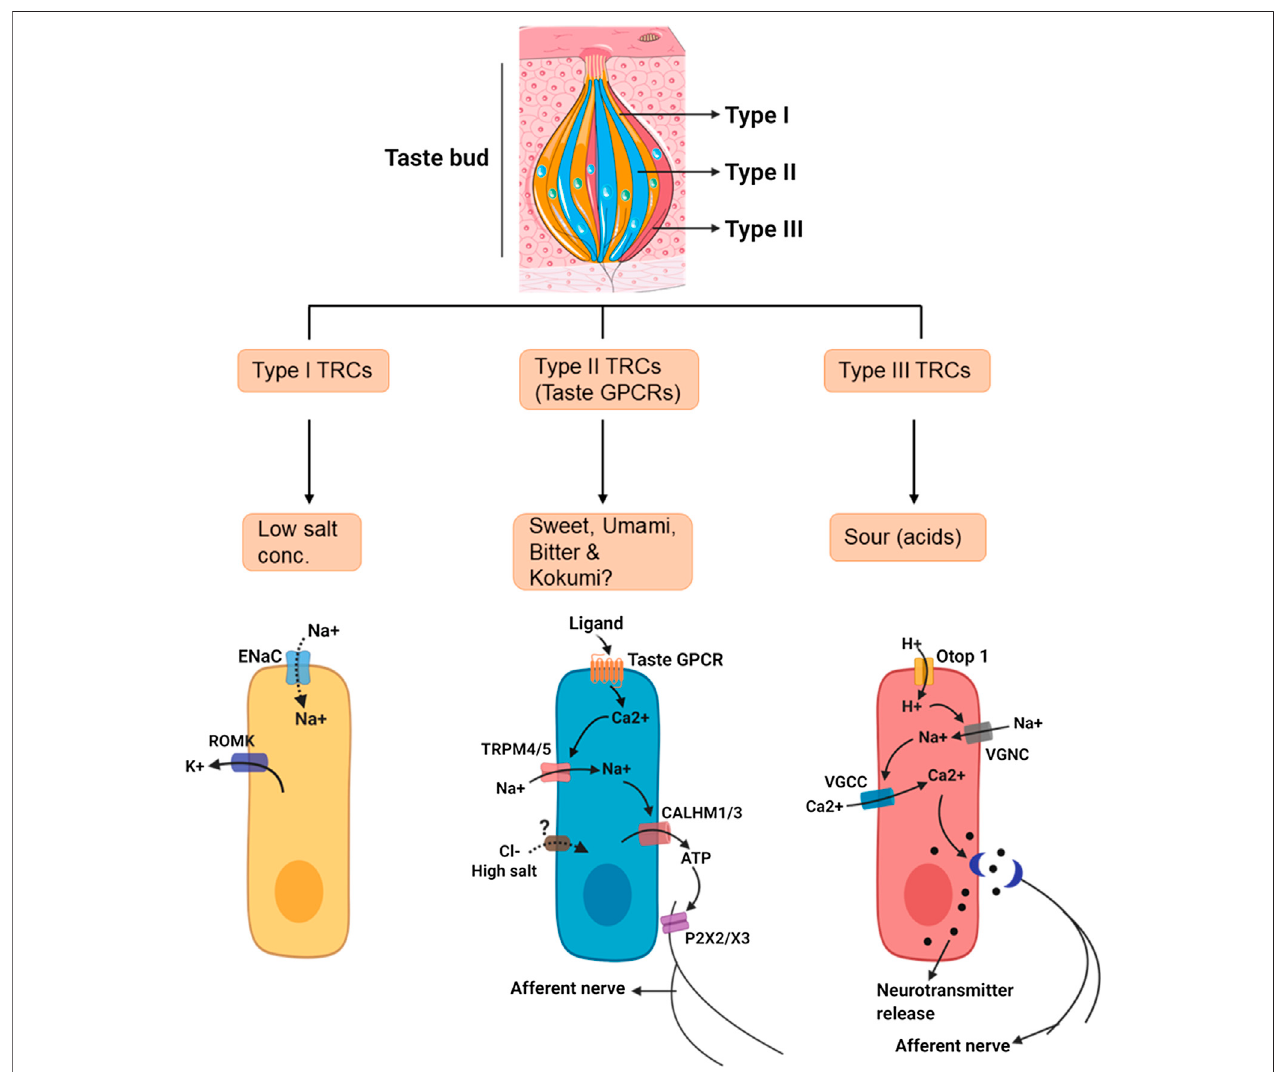
FIGURE2| Schematicrepresentationofdifferenttypesoftastereceptorcells(TRCs)intastebudwiththeirattributedtastemodalitiesandsignaltransduction.Type ITRCsexhibitasupportfunctionsimilartoglialcellsandexpressenzymesandtransportersthatremoveextracellularneurotransmitters(Lawtonetal.,2000;Barteletal., 2006; Vandenbeuch et al., 2013), and ion channels linked with the redistribution and spatial buffering of K+ (Dvoryanchikov et al., 2009). A subpopulation of type I cells are thought to be involved in low salt taste perception (Vandenbeuch et al., 2008) but this remains to be con fi rmed. Type II TRCs are receptor cells and express G protein-coupled receptors (GPCRs) on their surface that respond to sweet, umami and bitter tasting stimuli. The type II TRCs are fi ne-tuned and express either type 1 (TAS1R2/TAS1R3: sweet and TAS1R1/TAS1R3: umami) or type 2 taste (TAS2Rs; bitter) GPCRs and correspondingly respond to sweet/umami or bitter stimuli (Matsunami et al., 2000; DeFazio et al., 2006; Yoshida et al., 2009) (see also Table 2 for classi fi cation). Moreover, three isoforms of type 1 taste GPCRs (TAS1R1, TAS1R2 and TAS1R3) are often co-expressed and responses to both sweet and umami stimuli can be detected in the same cell (Kusuhara et al., 2013). Interestingly, recent studies reported a novel subpopulation of cells with type II TRCs that transduce a signal in response to high salt concentrations ( > 150 mM) (AI) (Roebber et al., 2019). Type III TRCs are the least abundant and sense sour stimuli through the proton selective channel, otopterin 1 (Tu et al., 2018; Zhang et al., 2019). As a consequence of expressing several synaptic proteins, they are termed presynaptic cells (DeFazio et al.,2006). Although both Type II and Type III TRCs require action potentials for transmitter release, their working mechanisms are quite different. Whereas, type III TRCs use a conventional synapse and SNARE mechanism like that in neuronstoaffectthereleaseofsynapticvesicles,typeIITRCsrelyonactionpotentialstotriggerthereleaseofATPthroughvoltagegatedchannels (DeFazioetal.,2006; Vandenbeuch et al., 2013) (see also Figures 1 , 3 ) (created with BioRender.com).